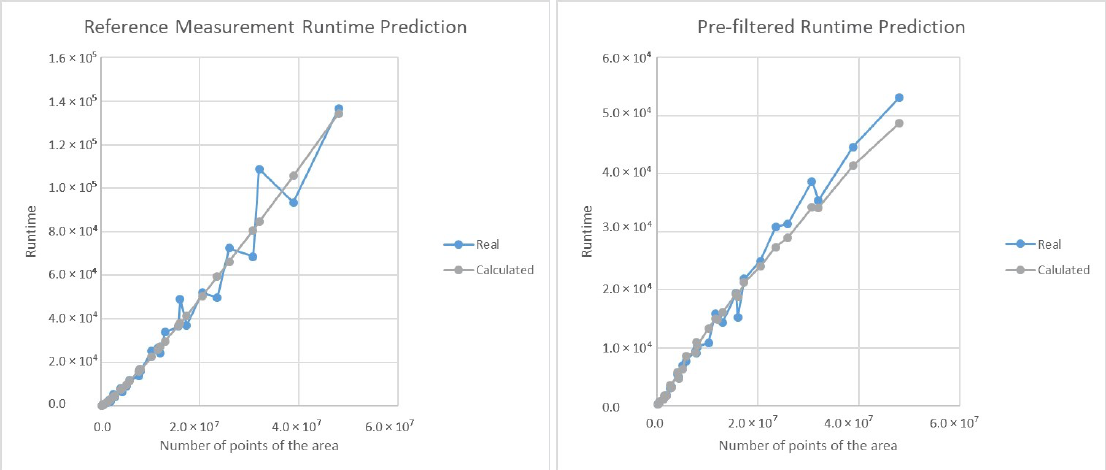
Figure 9. Calculated runtime according to predictions (13) and (14) and the real measured run times. The evaluation was based on the number of evaluated points of the area, regardless of the number of sensors.